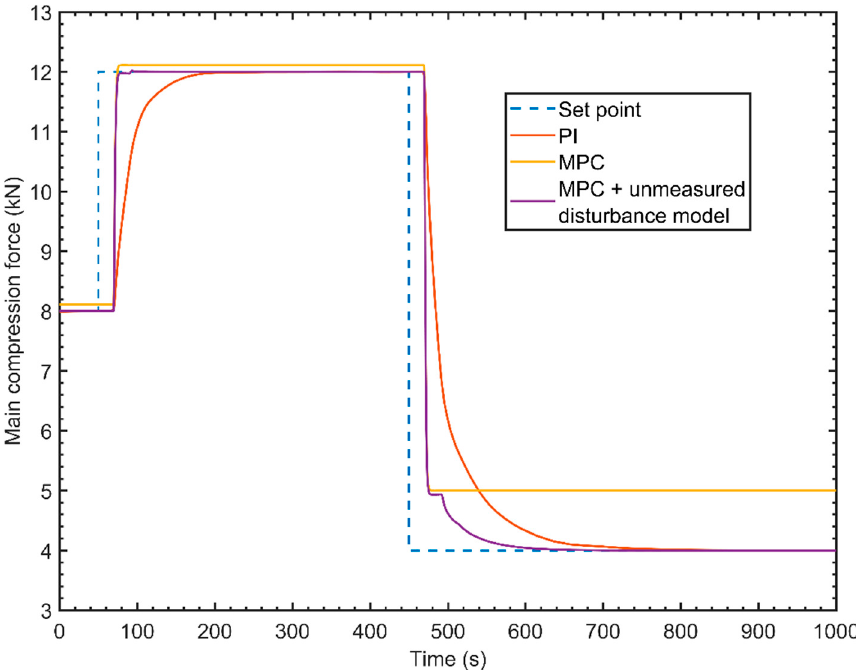
Figure 9. Control algorithm comparison. PI: Proportional Integral controller; MPC: Model predictive control.